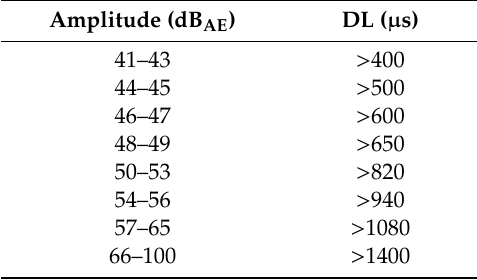
Table 2. Duration limits (DL) for the Swansong filter applied to AE signals, depending on its amplitude. The values proposed by